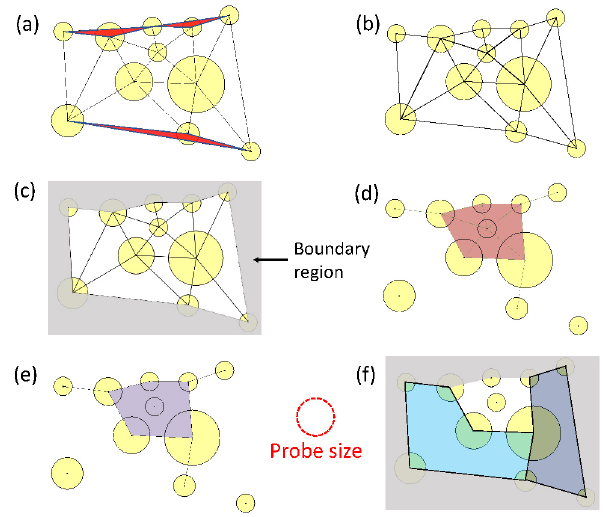
Fig. 20 Determining fiber-deficient areas from the dual triangulation: (a) dual triangulation, with boundary-artifact cells rendered in red, (b) refined dual triangulation, (c) boundary region, the complement of the refined dual triangulation, (d) α -complex, (e) α -shape, (f) detected fiber-deficient areas.